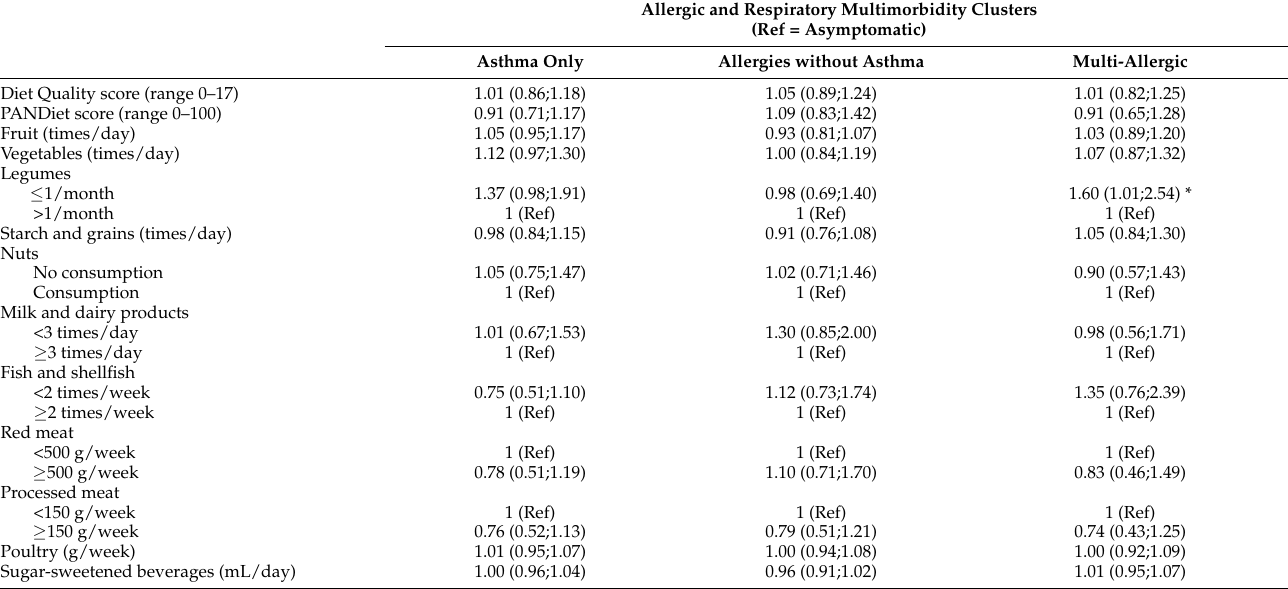
Values are % ( n ) or mean ± standard deviation. † p -values of Pearson chi-square test for categorical dietary exposures and of ANOVA test for continuous dietary exposures. * p -value < 0.05. Table 4. Adjusted association between maternal diet during pregnancy and allergic and respiratory multimorbidity clusters up to 8 years of age ( n = 1316). Allergic and Respiratory Multimorbidity Clusters (Ref = Asymptomatic) Asthma Only Allergies without